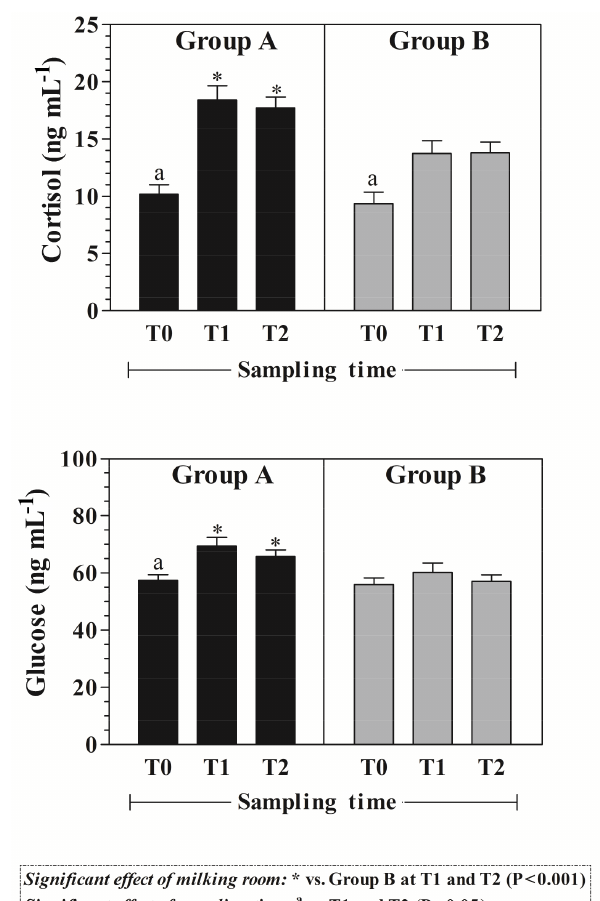
Figure 2. Mean values ± standard deviation ( ± SD) of plasma cor- tisol and glucose obtained from dairy ewes (Group A and Group B) at T 0 (2h before milking procedure at 06:00), at T 1 (immediately after the animals entered the milking room, about 08:00) and at T 2 (after milking